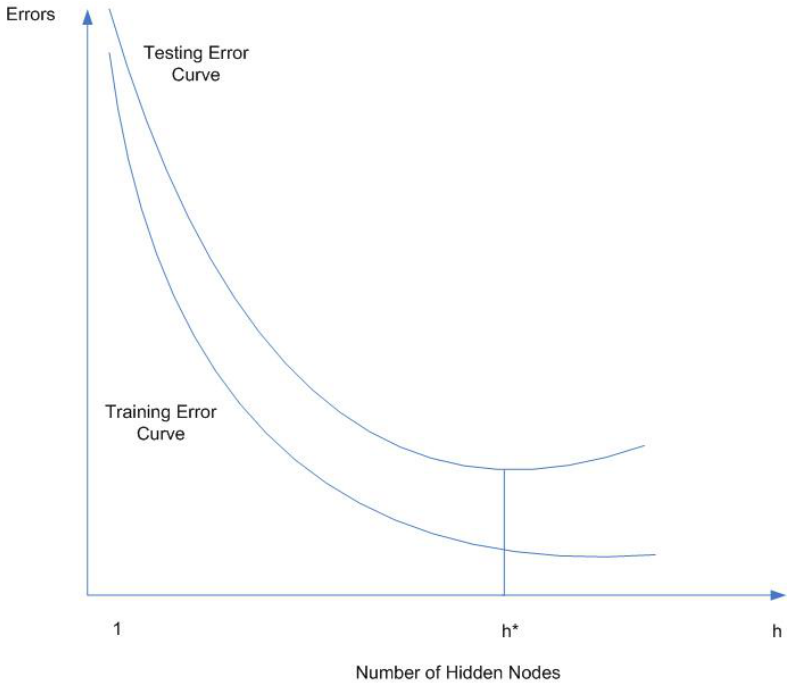
Figure 6. MLP error curves vs. number of hidden